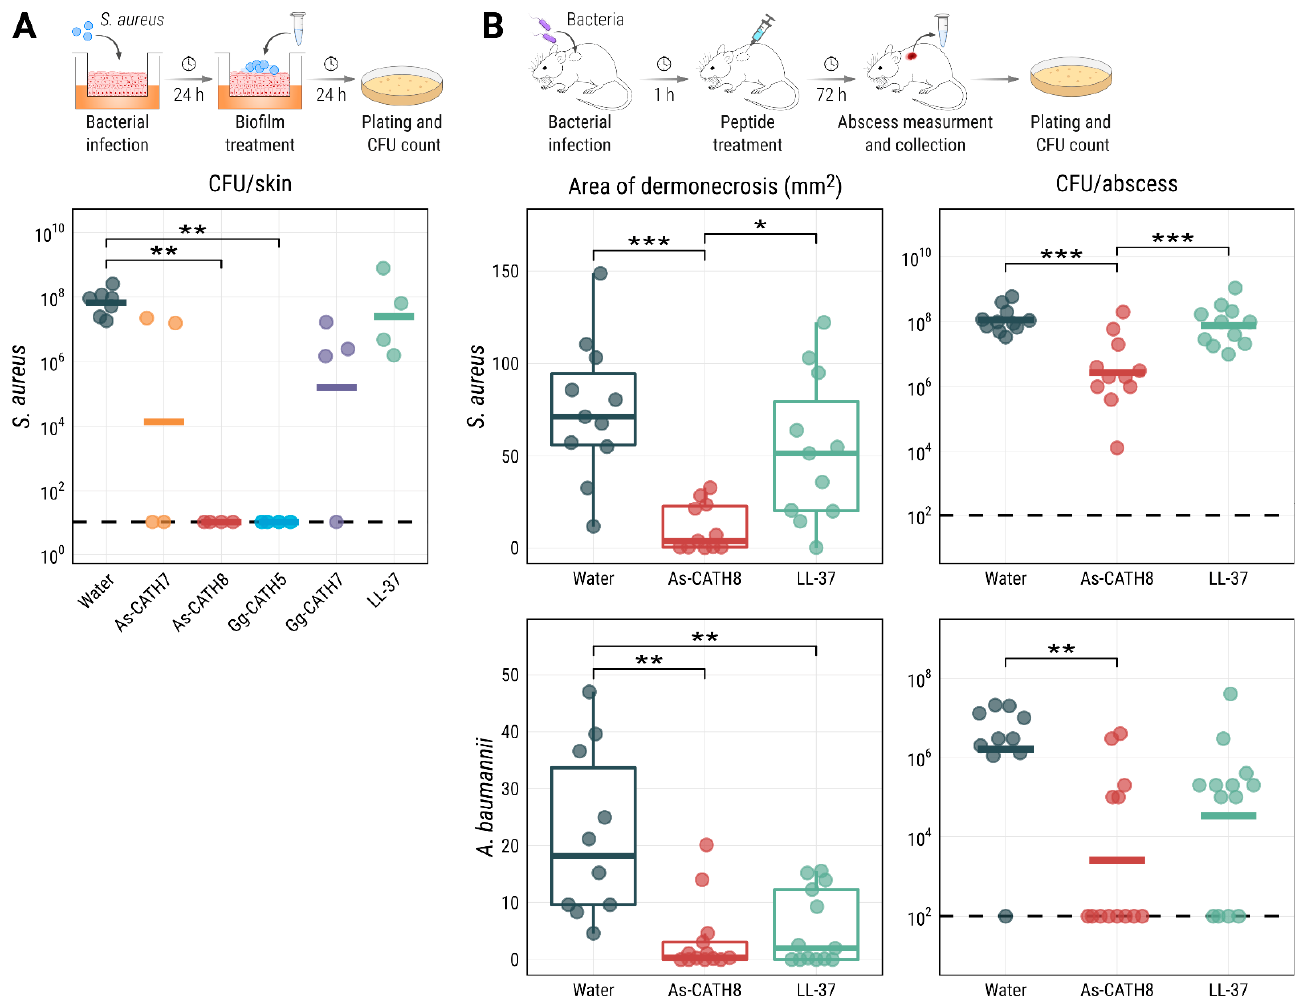
Figure 3. Anti-infective capacity of As-CATH8 and LL-37 in a human skin organoid ( A ) and a mu- rine abscess ( B ) model. ( A ) The ability of crocCATHs to eradicate pre-formed S. aureus biofilms